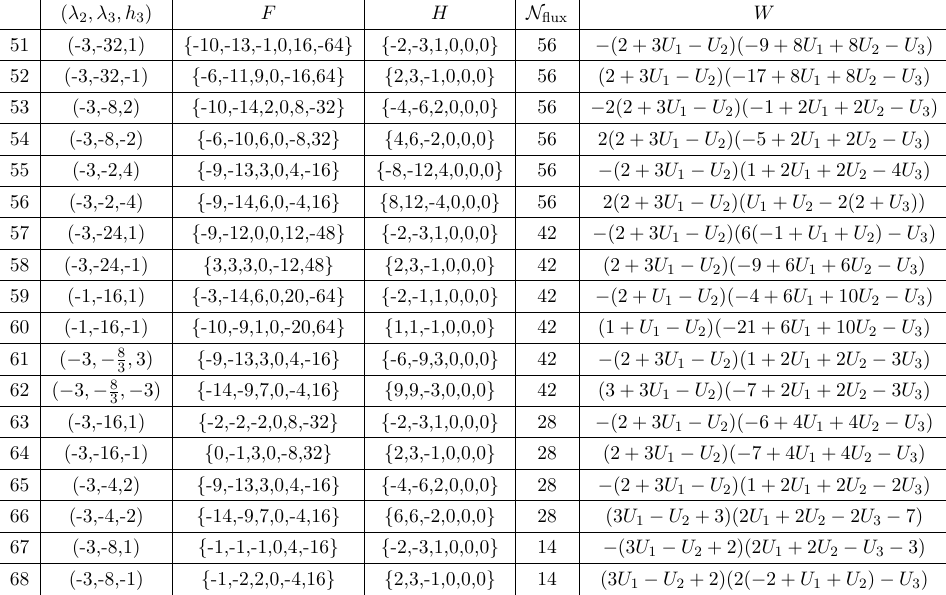
Table 2 . Representatives of families of integer fluxes for solutions with W = 0 and 1 flat direction, Part 2